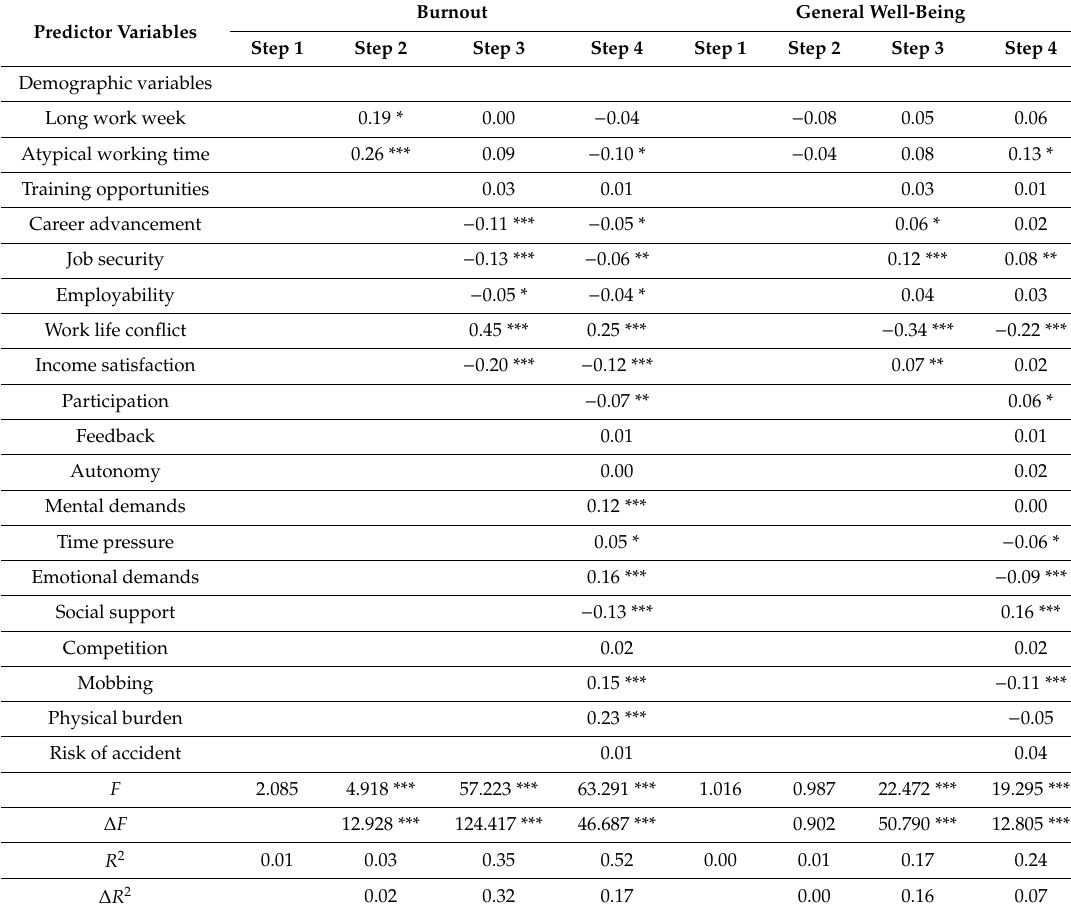
Table 7. Hierarchical regression analyses with burnout and general well-being as outcome variables.